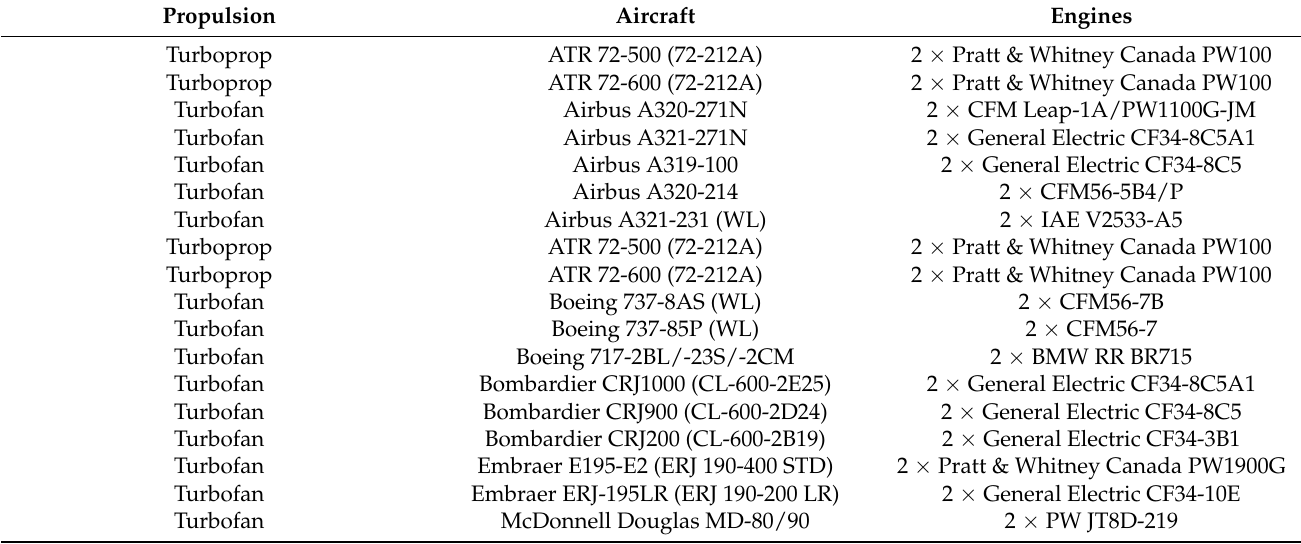
Table A3. List of Representative Engines Considered in the